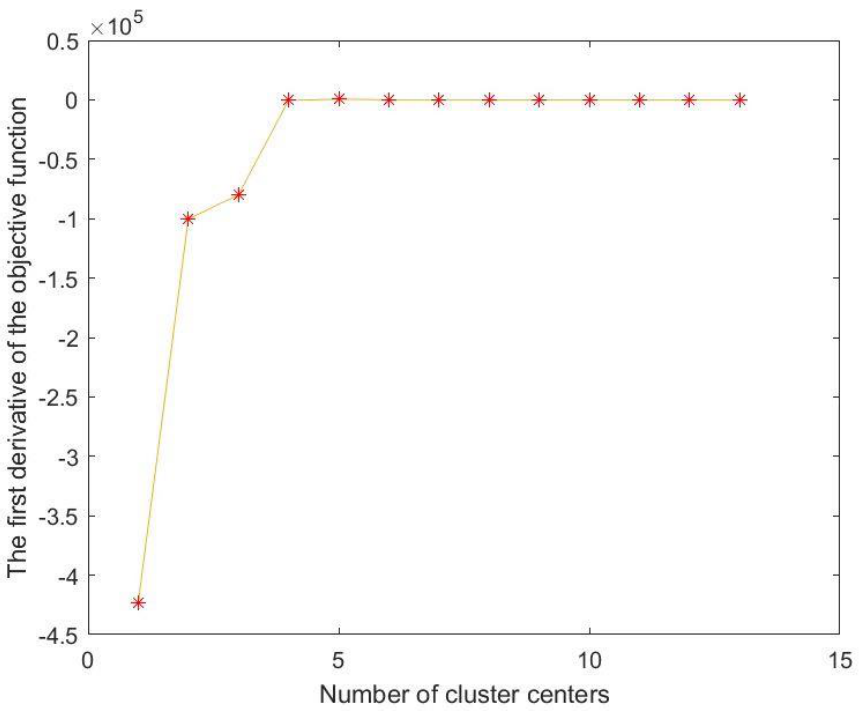
Table 2. Fuzzy membership matrix.